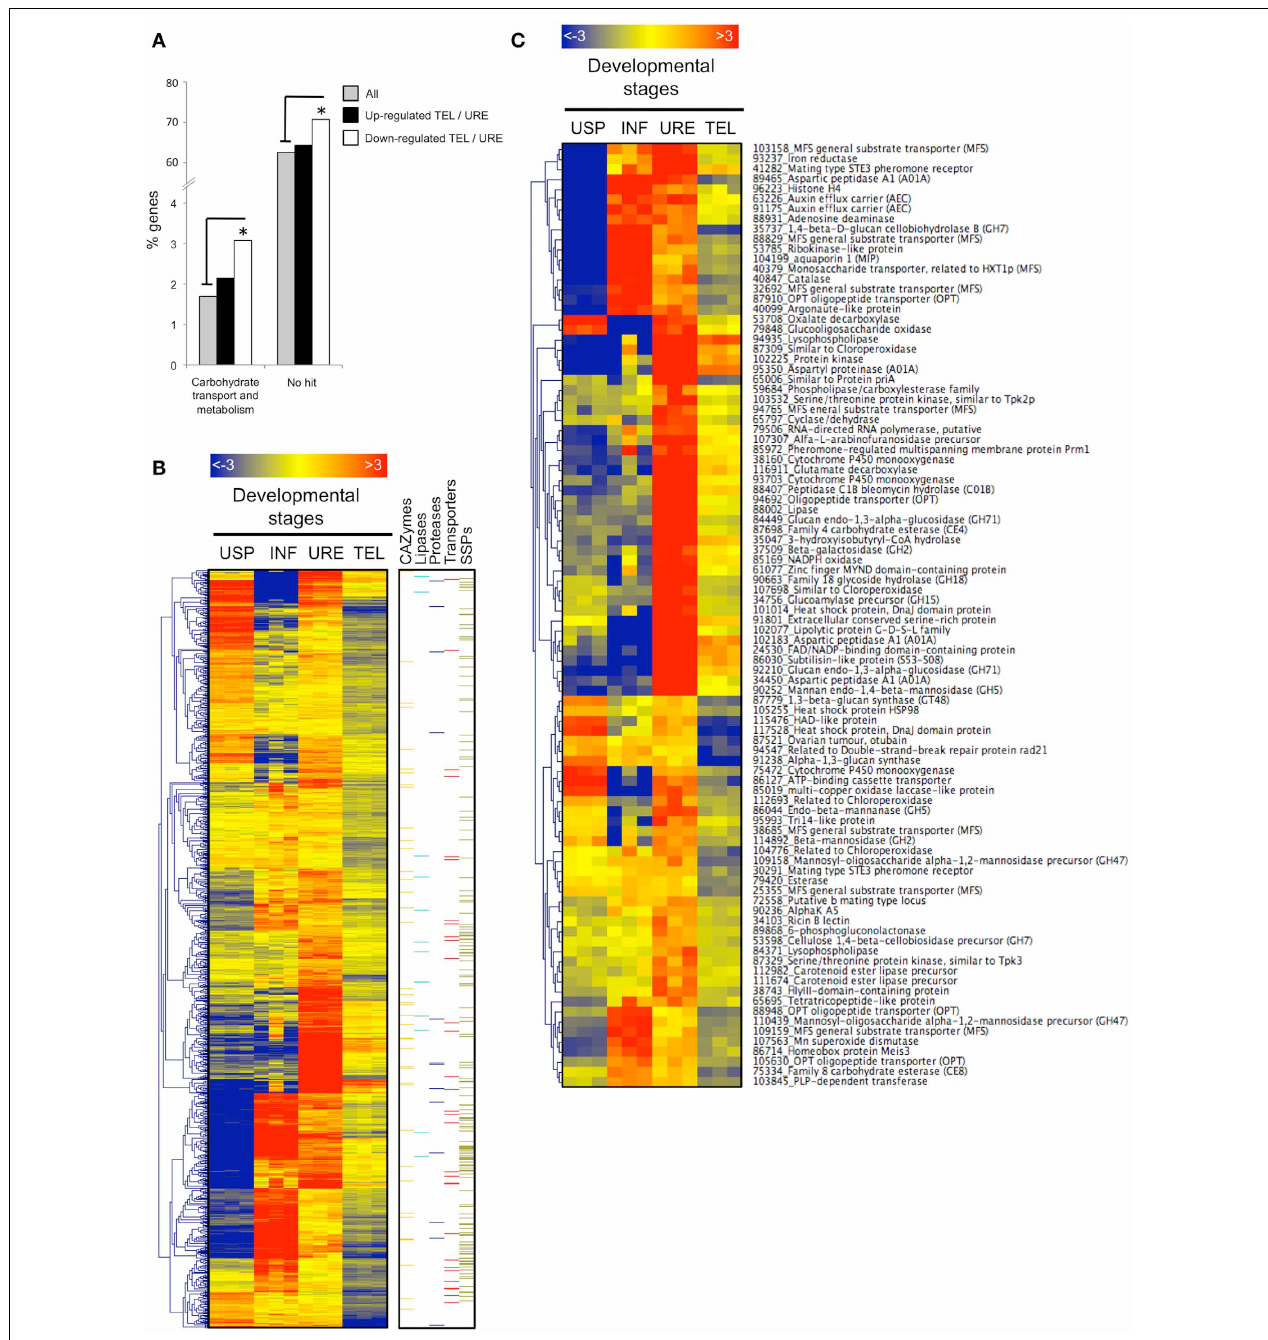
Over-represented (red) or under-represented (blue) transcripts are depicted as log 2 fold-changes relative to the mean expression level measured across all four stages. USP, urediniospores; INF, poplar infected leaves; URE, uredinia; TEL, telia. On the right side, genes belonging to five pathogenicity-related categories (carbohydrate active-enzymes, lipases, proteases, transporters, and small secreted proteins) are highlighted with color bars. (C) Among the genes presented in the panel (B) , only those showing high transcript repression in telia compared with uredinia (log 2 FC < − 2, p < 0 . 05) and having a functional annotation (based on the swissprot database) are highlighted. JGI protein identification number and the associated function are